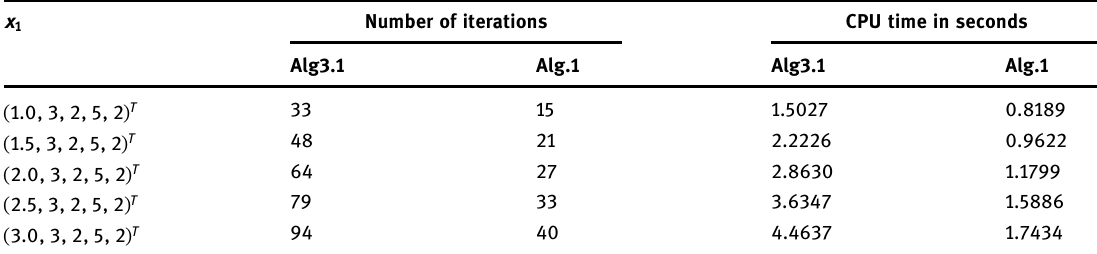
Table 1: Example 6.1: Numerical values of Algorithm 1 and Algorithm 3.1 in [ 31 ]